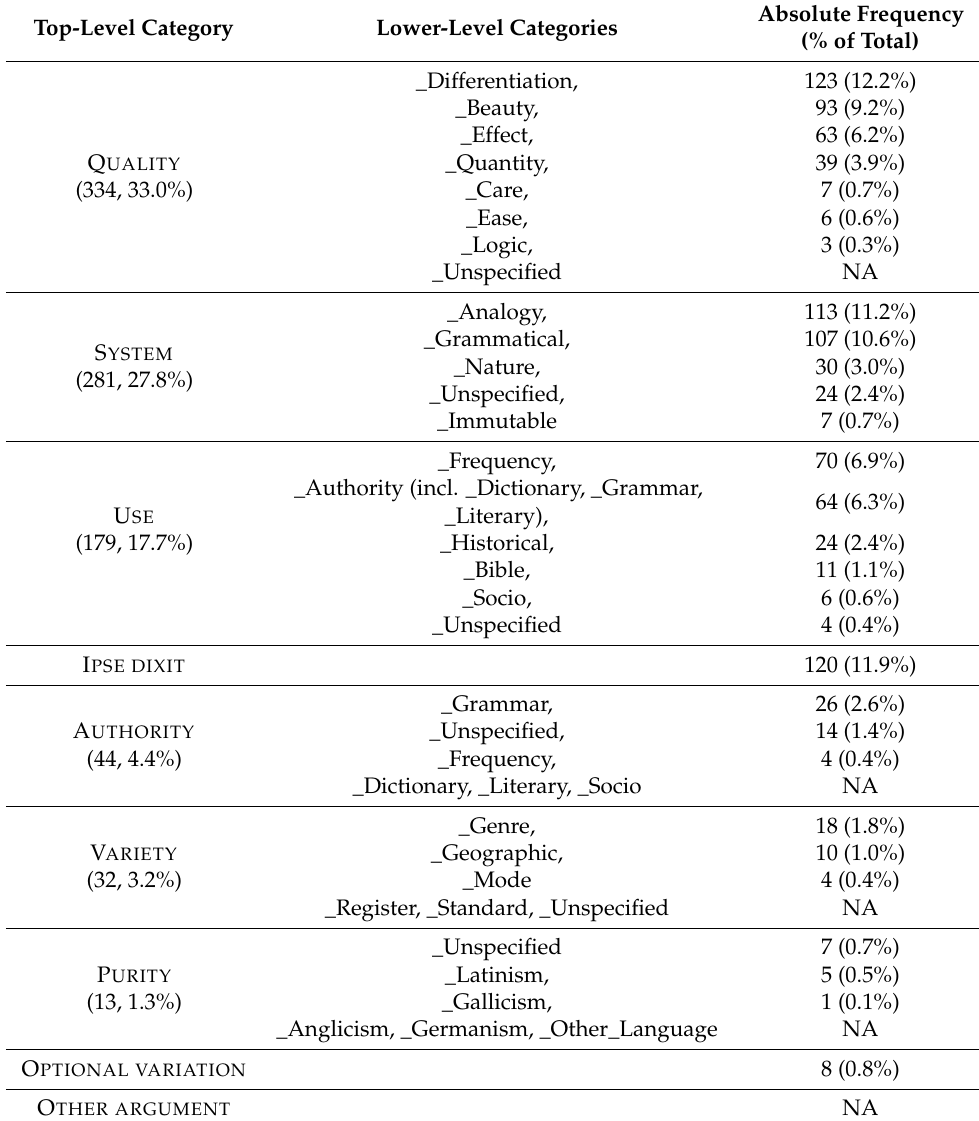
Table 4. Absolute frequency (and percentage of total number of arguments) of top- and lower-level categories of arguments used in normative works on Standard Dutch from ca. 1550 to 1650 (in order of